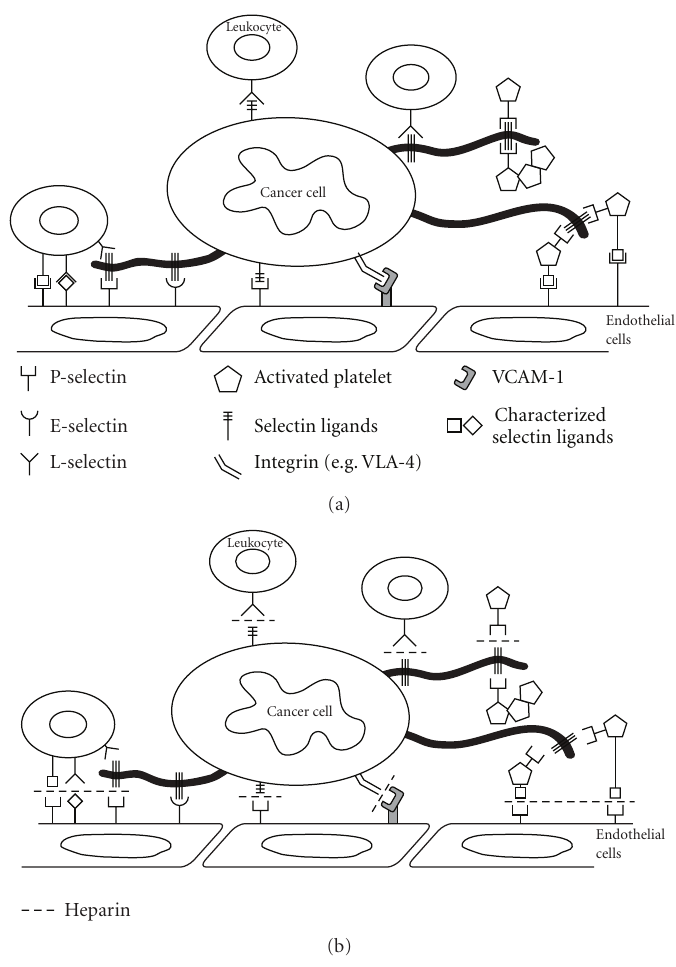
Figure 1: Selectins and integrins contribute to metastatic spread. (a) Schematic presentation of selectin- and integrin-mediated cancer cell interactions with several blood constituents (e.g., platelets, leukocytes, and endothelial cells) during hematogenous metastasis. (b) Heparin application in mouse models blocks both P- and L-selectin-mediated; and VLA4-mediated interactions of cancer cells within blood circulation thereby a ff ecting